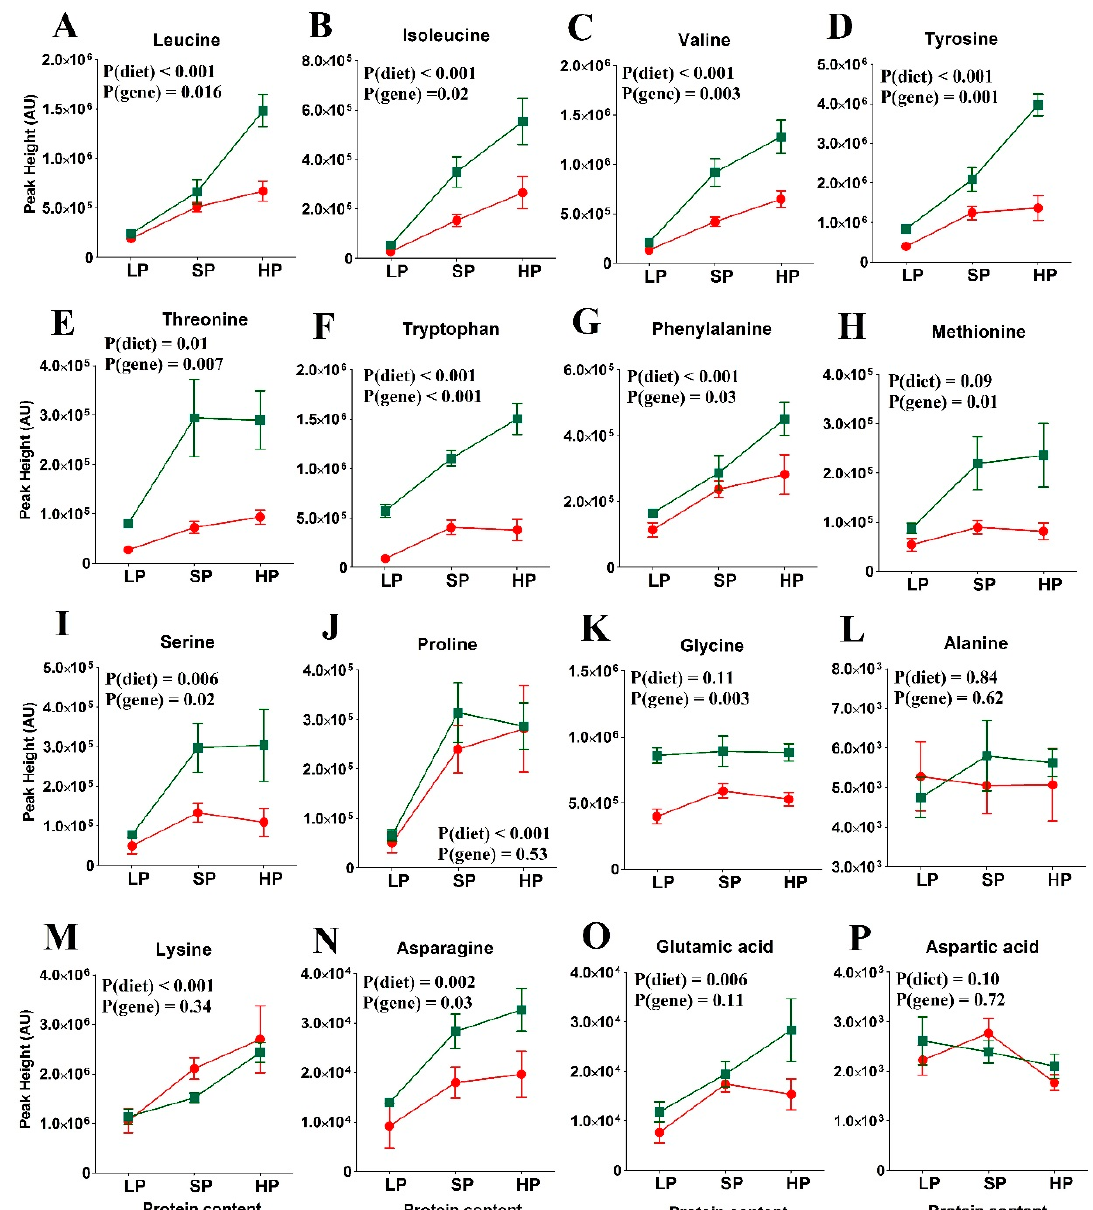
Figure 3. Postprandial amino acid abundance in SLC6A19 ko (red) and wt (green) mice on diets with low (LP), standard (SP), or high protein (HP) contents ( n = 5 per group). Amino acids: (A) Leucine, (B), Isoleucine, (C) Valine, (D) Tyrosine, (E) Threonine, (F) Tryptophan, (G) Phenylalanine, (H) Methionine, (I) Serine, (J) Proline, (K) Glycine, (L) Alanine, (M) Lysine, (N) Asparagine, (O) Glutamic acid and (P) Aspartic acid. Levels of all essential amino acids positively correlated with the dietary protein content in the wt mice. SLC6A19 ko mice exhibited reduced levels of neutral amino acids due to their dependence on SLC6A19 for amino acid absorption. Note the most prominent di ff erence in plasma amino acid levels between SLC6A19 ko and wt was observed following the HP diet. Non-essential amino acids showed no di ff erence between SLC6A19 ko and wt mice. The data points represent x ± SEM ( n = 5 per group). p -values were calculated by ANOVA comparing within-group and between-group variance of the diet e ff ects (diet) and genotype e ff ects (gene).